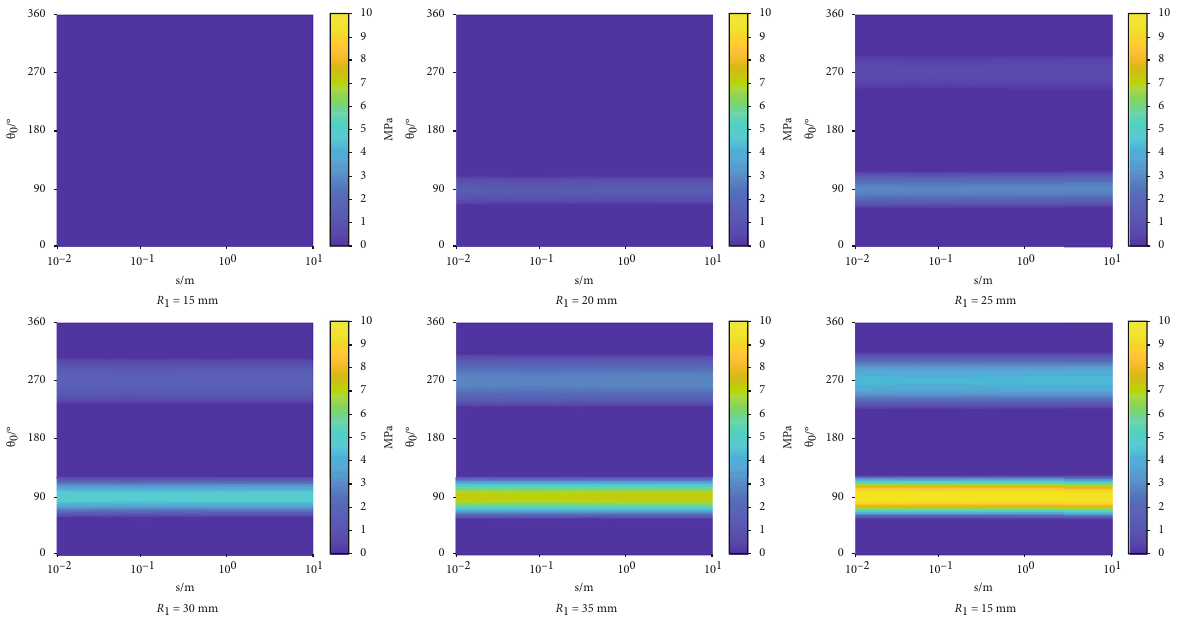
Figure 11: Maximum tensile stress increasing region with di ff erent radius of radial borehole